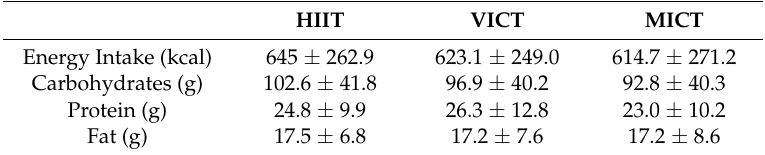
Table 2. Energy intake and macronutrients during ad libitum buffet